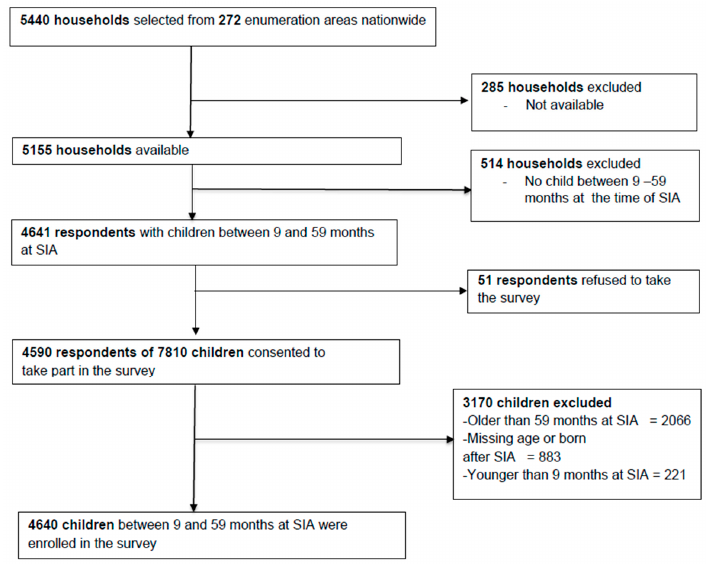
Figure 1. Study flow diagram. Table 1. Participants and household